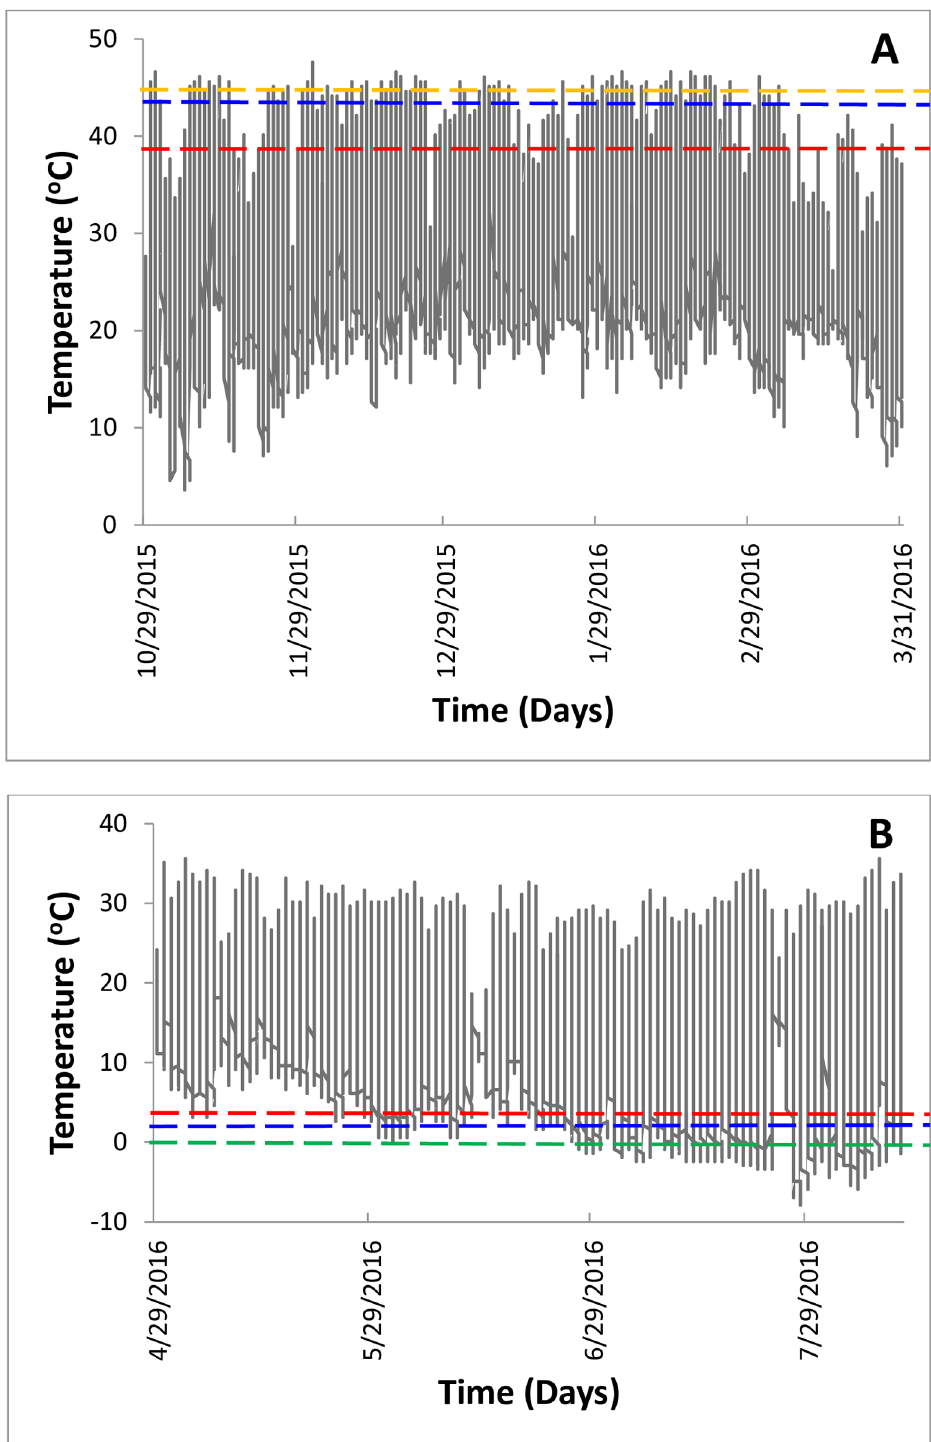
Fig 4. Microclimatic temperature data in (A) austral summer (October 2015 –March 2016) and (B) winter (April—July 2016) from a maize field, Tswana Foods Farm, Glen Valley, Gaborone, Botswana (S24.60213; E25.97820; 953m.a.s.l), hosting both C . sesamiae and C . flavipes . Blue and red dotted lines represent CT max and CT min for C . flavipes and C . sesamiae respectively whereas orange and green dotted lines represent heat knockdown and chill coma temperature respectively for both species.